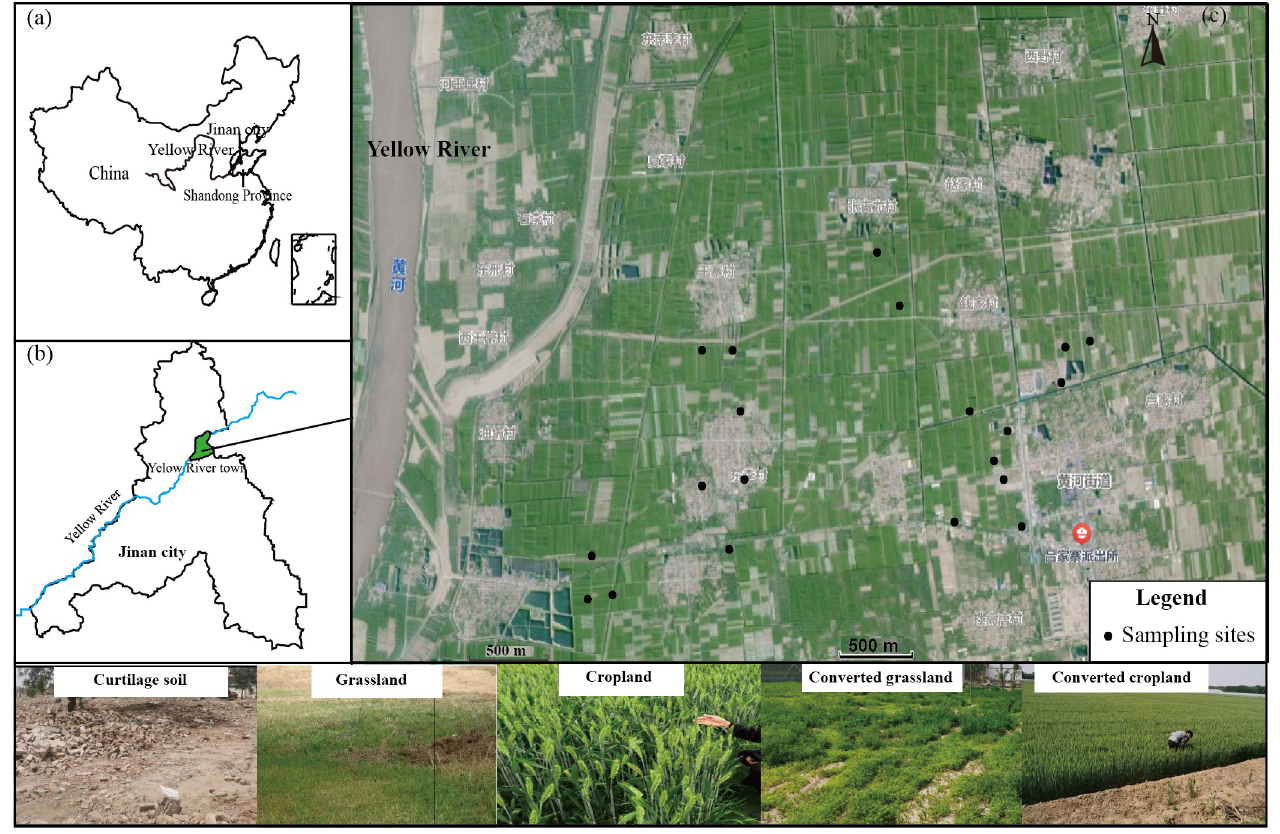
Fig 1. Sampling sites and surrounding environments. The site of Jinan city and Shandong Province (a) The site of Yellow River town (b).The sampling sites and surroundings in the Yellow River town (c). The data information is obtained from Landset 8 OLI_TIRS with data identification of LC81220342021147LGN00, which is provided by Geospatial Data Cloud site, Computer Network Information Center, Chinese Academy of Sciences. (http:// www.gscloud.cn).